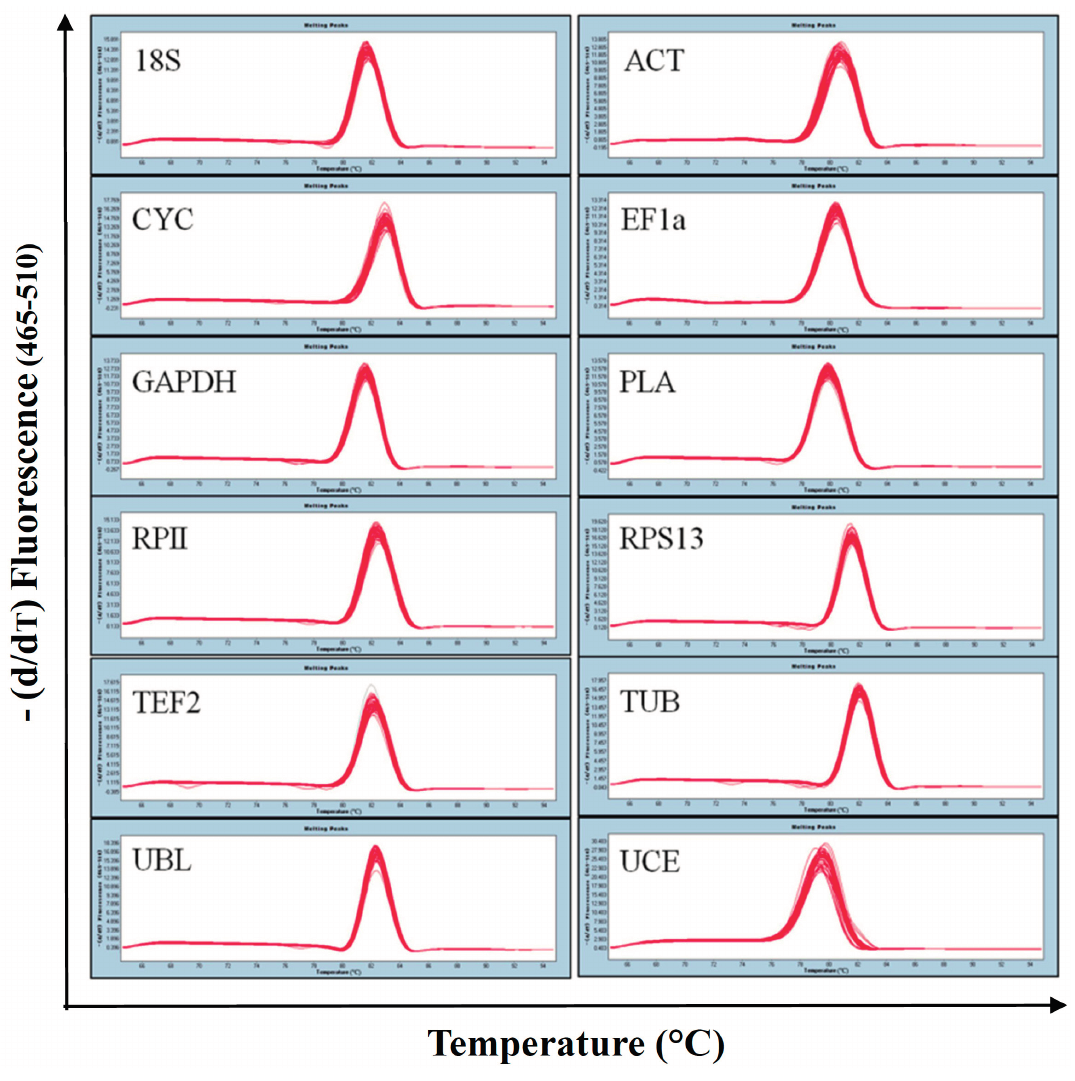
Figure 1. Melting curves for the twelve candidate reference genes. The melting temperature of each amplicon is visualized by plotting the negative derivative of the change in fluorescence divided by the change in temperature in relation to the temperature ( − (d/dT) Fluorescence